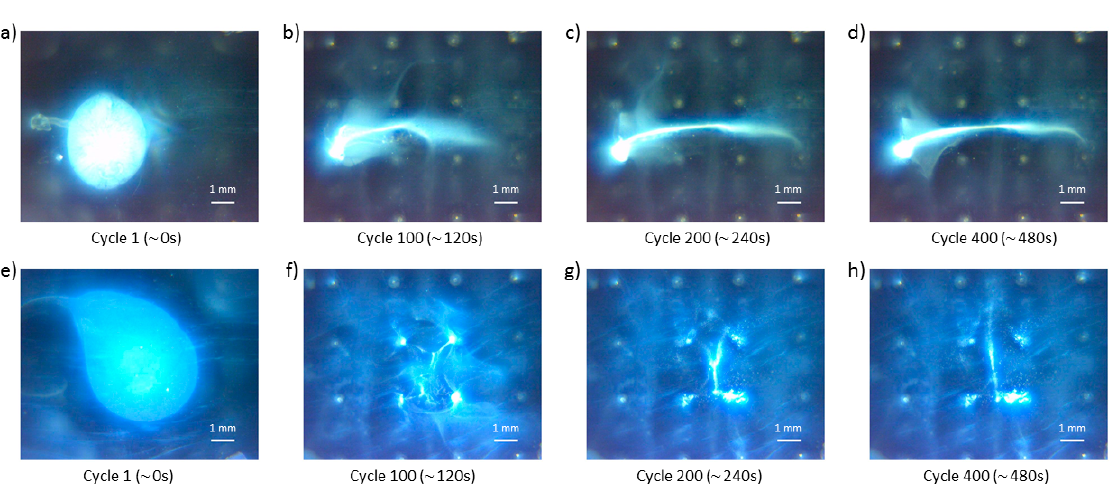
Figure 15. ( a – d ) “Horizontal” and ( e–h ) “vertical” midline depositions snapshots. The bottom right white line length is 1 mm.